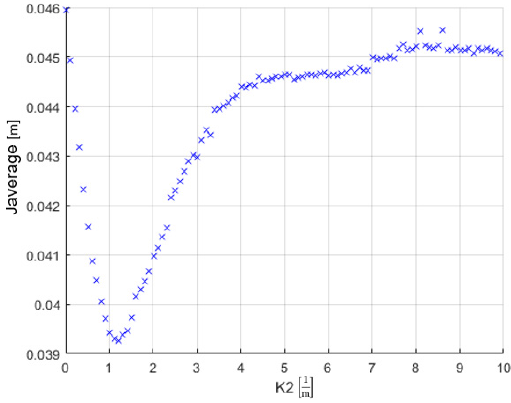
Figure 9. The optimal value of K 2 .